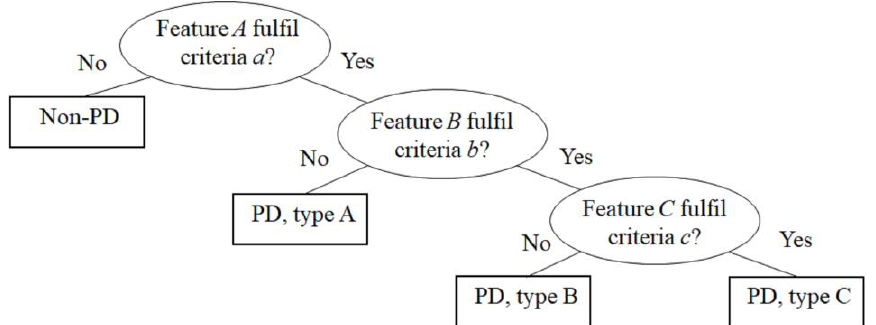
Figure 9. DT on classification processes.